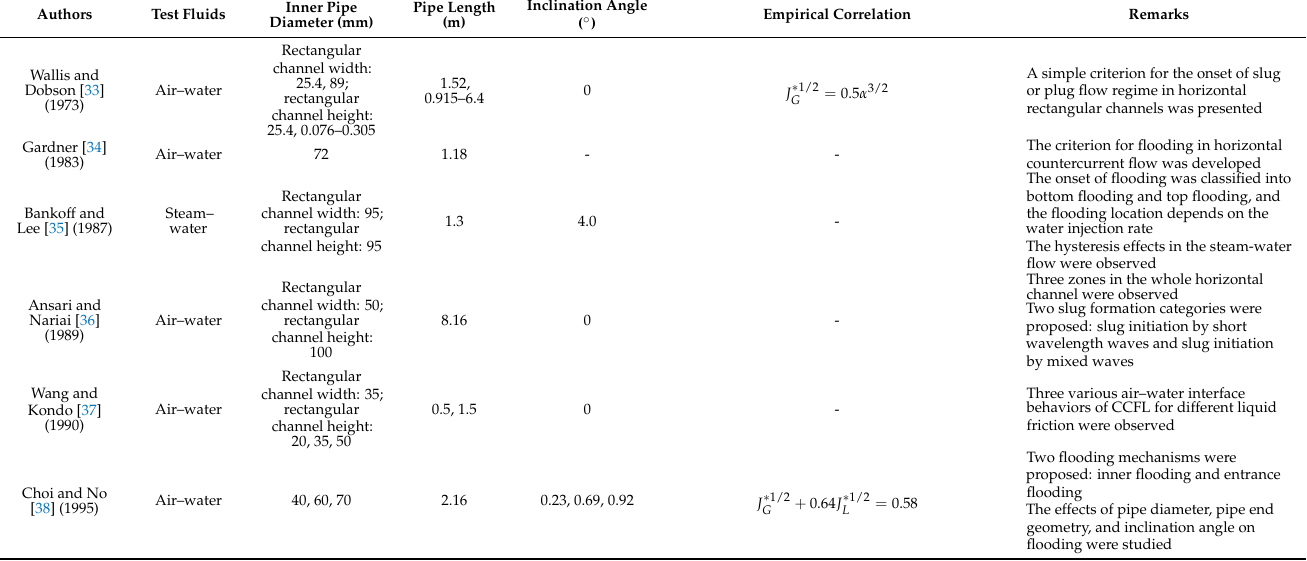
Table 2. Summary of the experimental investigations on the CCFL in horizontal and nearly horizon- tal